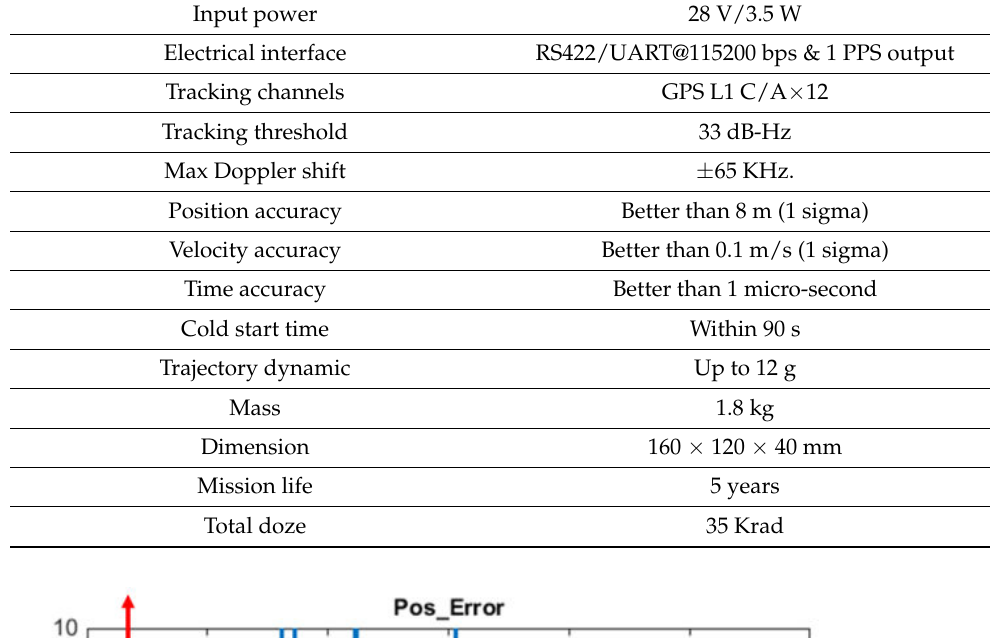
Table 1. The specifications of the NSPO GPSR.